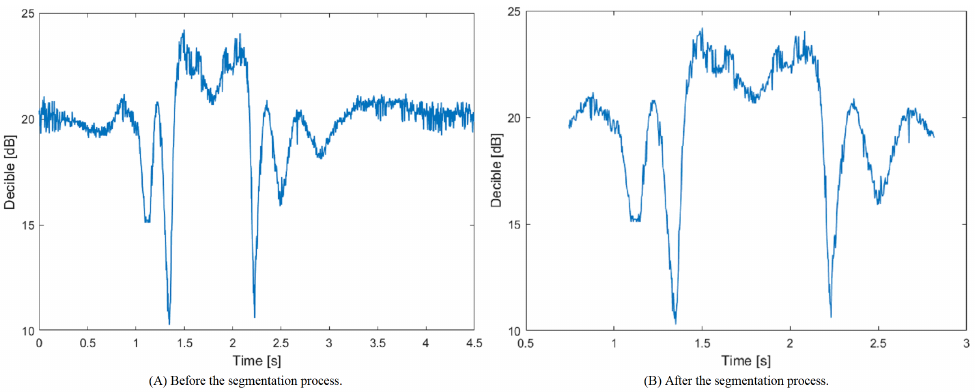
Figure 9. The effect of the segmentation stage on a recorded